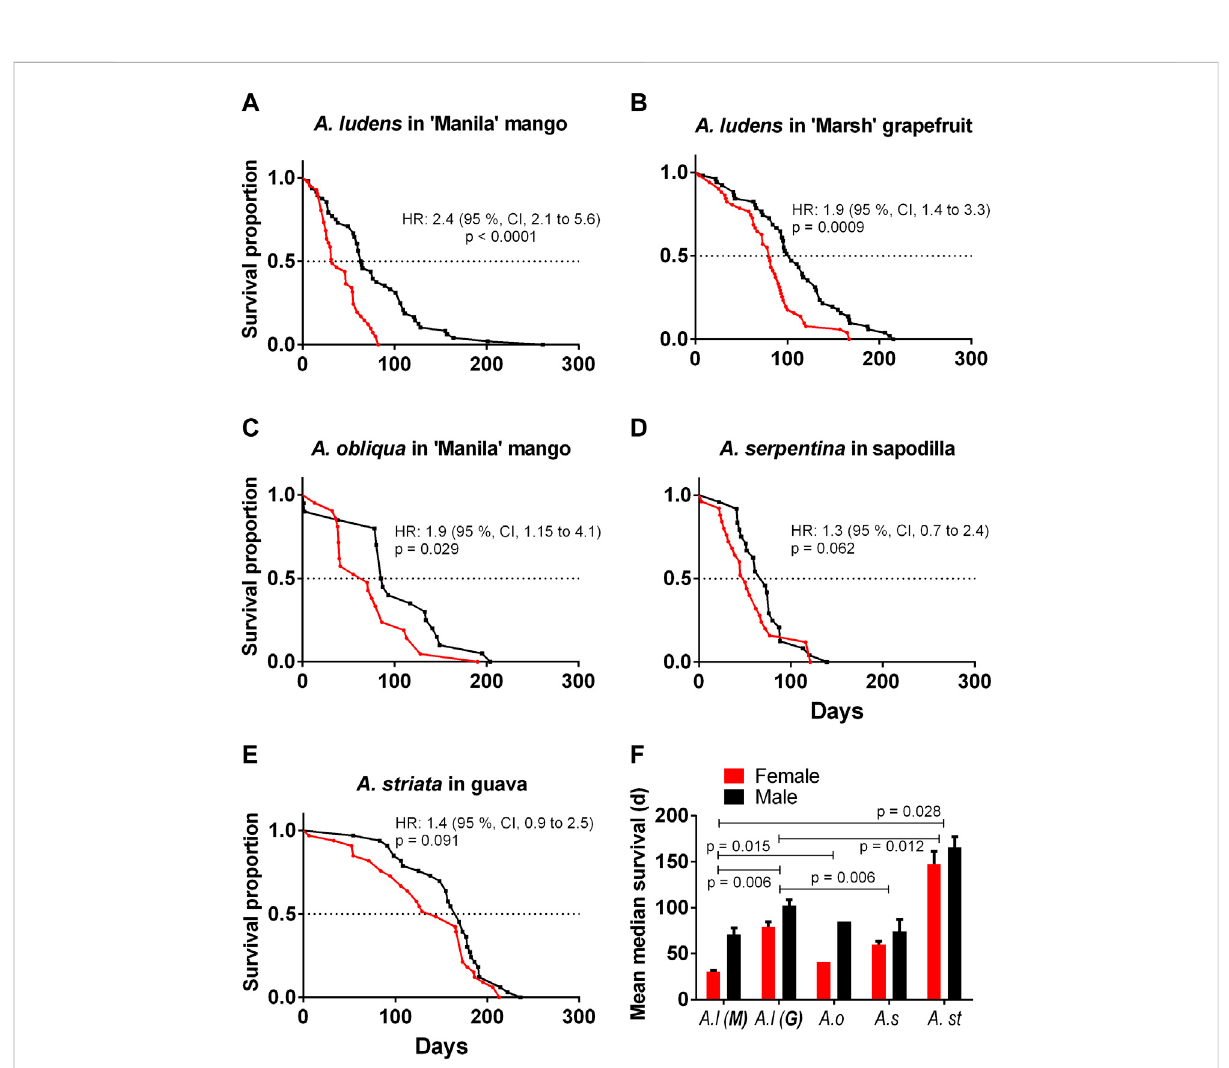
FIGURE 6 Kaplan-Meiersurvival curves offour pestiferous Anastrepha spp. under fi eldconditions (A) A.ludens reared inmango in Apazapan, (B) A.ludens reared in grapefruit in Tolome; (C) A. obliqua reared in mango in Actopan; (D) A. serpentina reared in sapodilla in Apazapan; (E) A. striata reared in guava. The red lines show female survival, and the black ones male survival. (F) Mean ± SE of median survival (days) of females and males of the four Anastrepha species